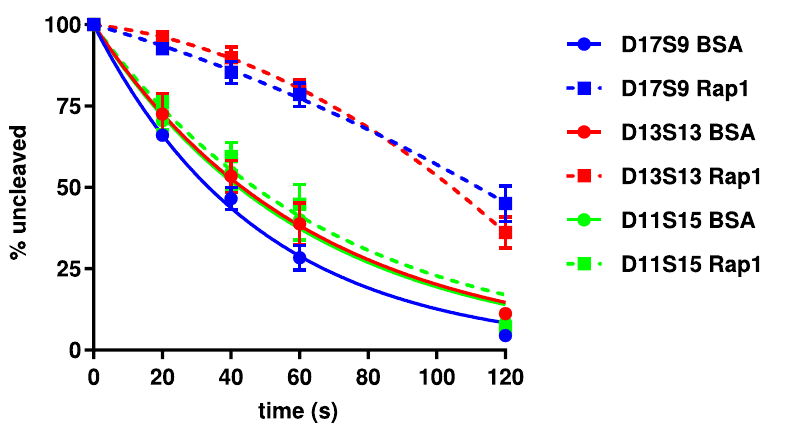
Figure 8. Graph summarizing the results from DEPA experiments assessing Rap1 5 ′ end protection of the indicated telomere substrates. Each point is the average and error bars ± SEM of three